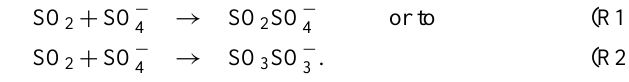
Figure 1. Main reactions/equilibria in the SO 2 + SO − ( H 2 O ) 0–2 SO 3 SO − 3